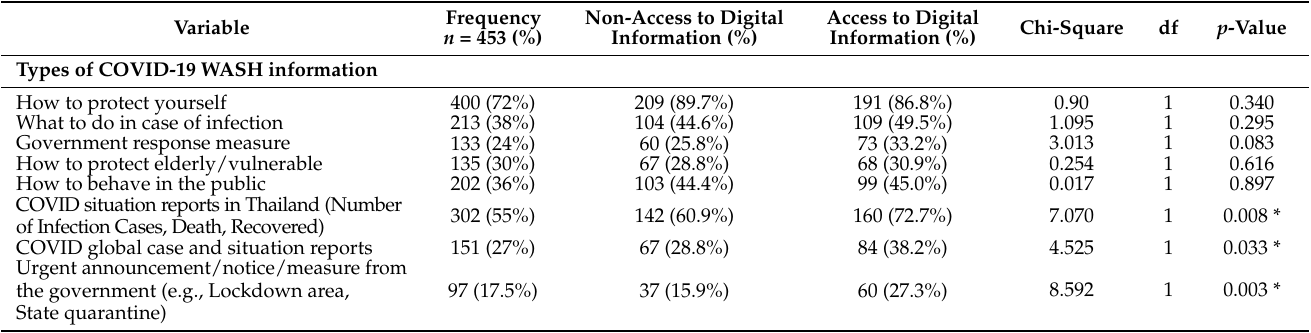
Table 2. Awareness and practices of COVID-19 protection.